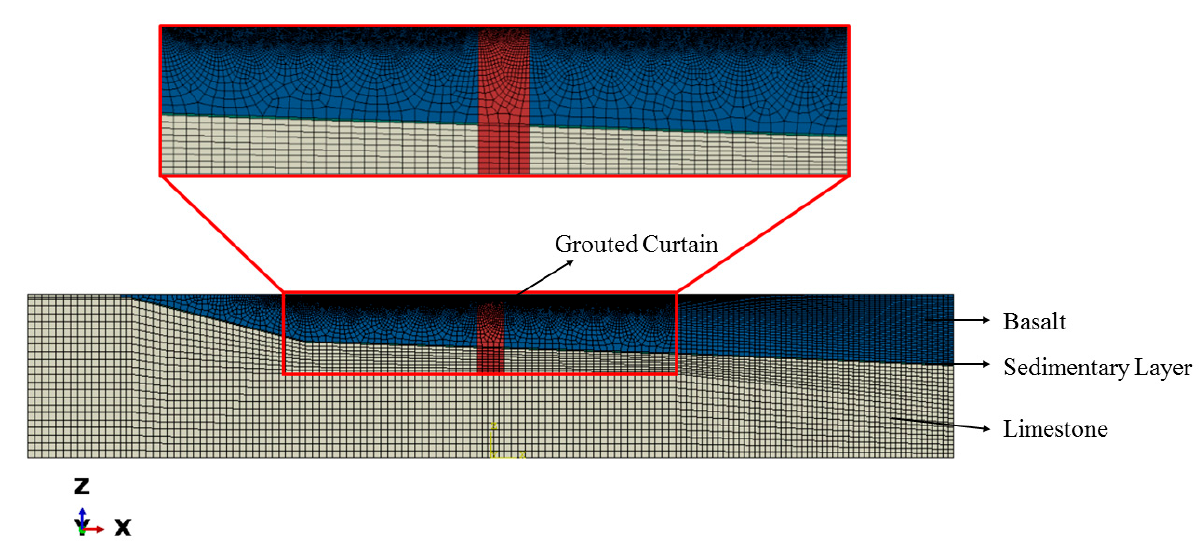
Figure 6. Finite element mesh.